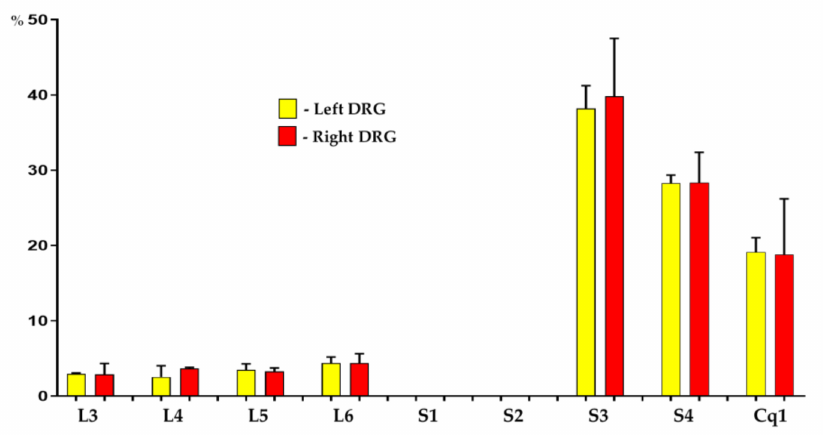
Figure 1. Bar diagram showing the distribution pattern of Fast Blue-positive (FB + ), bladder projecting cells in the porcine dorsal root ganglia (DRG) ipsi- (red bars) and contralateral (yellow bars) to the sites of tracer injections into the organ wall of control group. Data are pooled and presented as mean ± standard